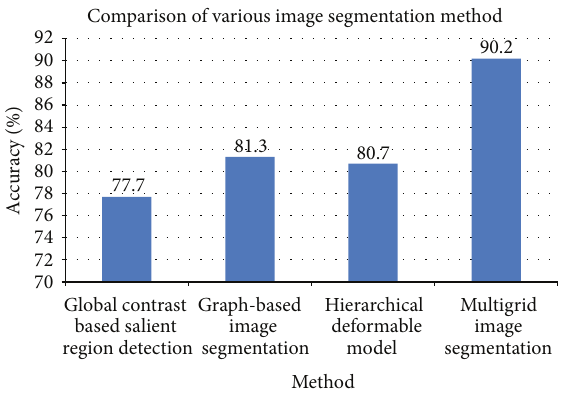
Figure 7: Accuracy comparison result of various image segmenta- tion methods.